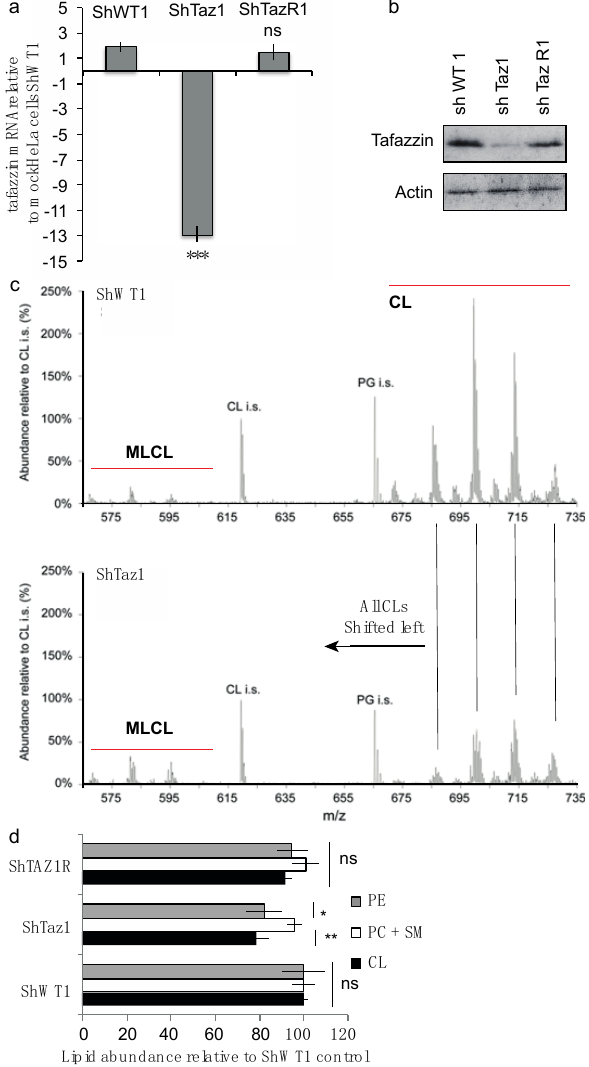
Figure 1. General biochemical characterization of the different cell lines (ShWT1; control, ShTaz1; Tafazzin knockdown and ShTazR1; Tafazzin revertant). ( a ) Measurement of tafazzin mRNA for each cell line (ShWT1, ShTaz1, and ShTazR1) relative to mock HeLa cells as control. Data show mean of 5